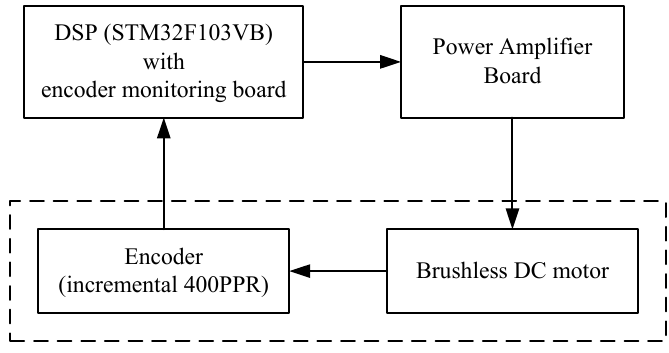
Figure 7. Experiment configuration. PPR: pulse per rotation.